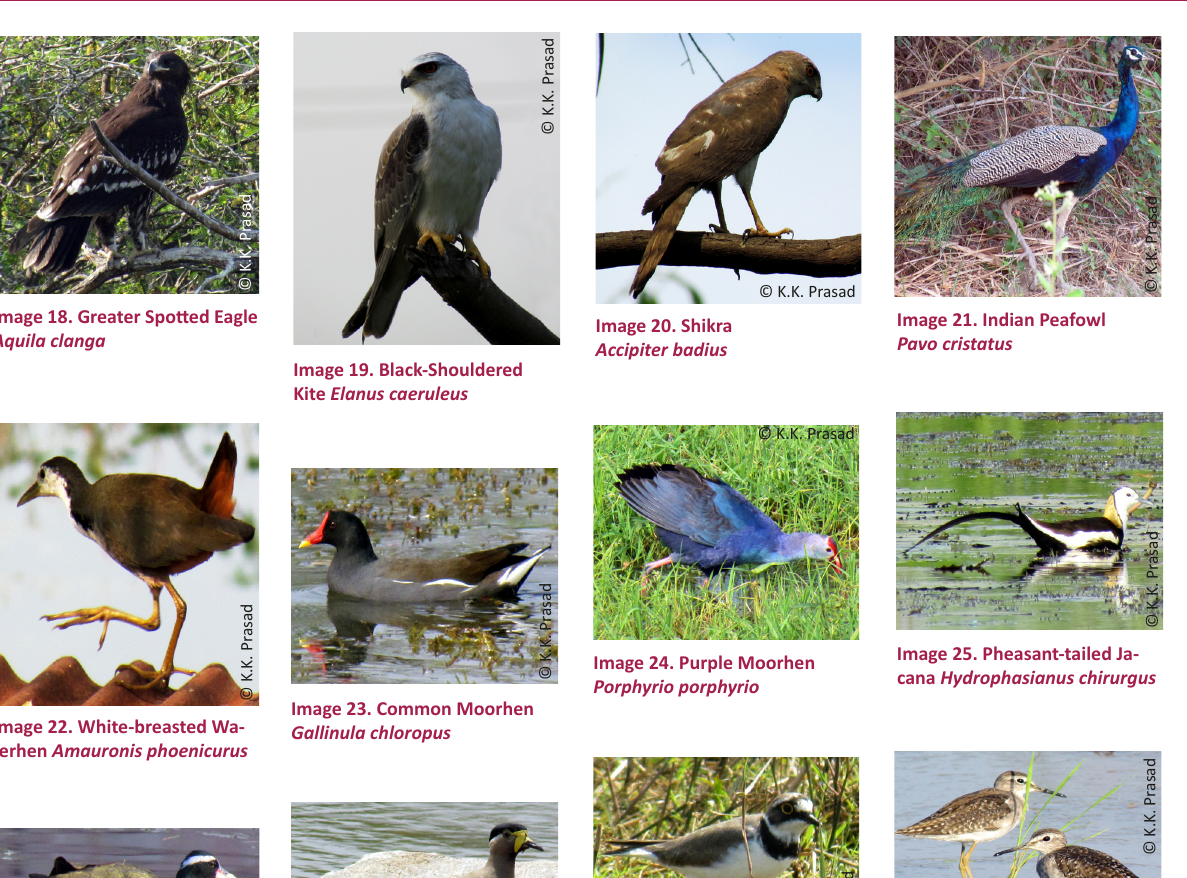
Image 29. Wood Sandpiper Tringa glareola